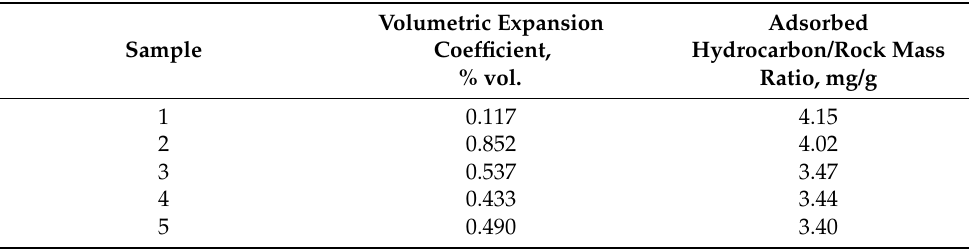
Table 4. Results of the crushed rock swelling experiments in the presence of the hydrocarbon-based fracturing fluid.